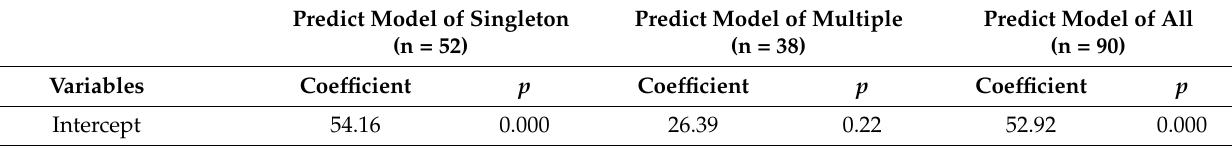
Table 3. The effect factors of perceived stress in mothers with preterm